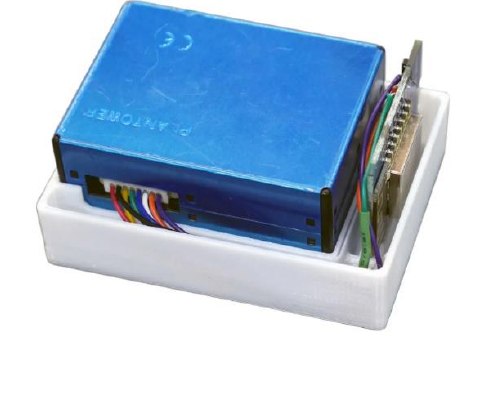
Figure 5. Connection between the WEMOS and the PM5003 sensor